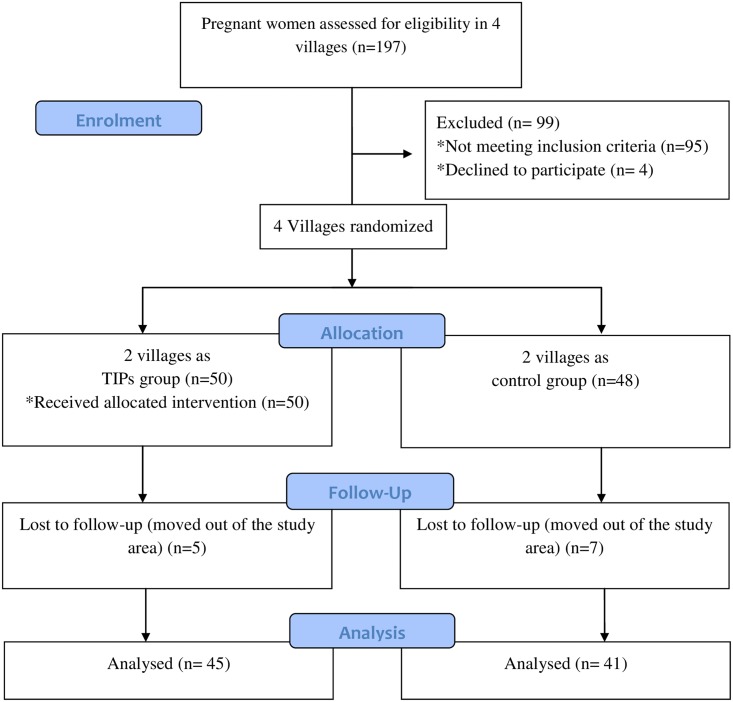
CONSORT flow diagram of the study participants.